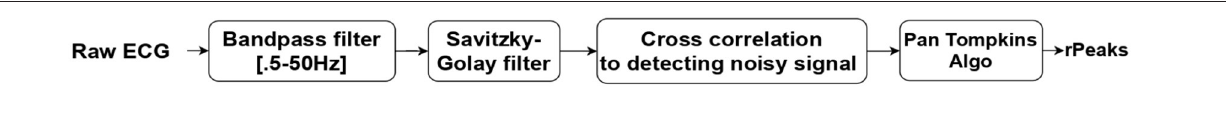
FIGURE 6 | Analysis of ECG quality, QRS complex, and R-peak detection.